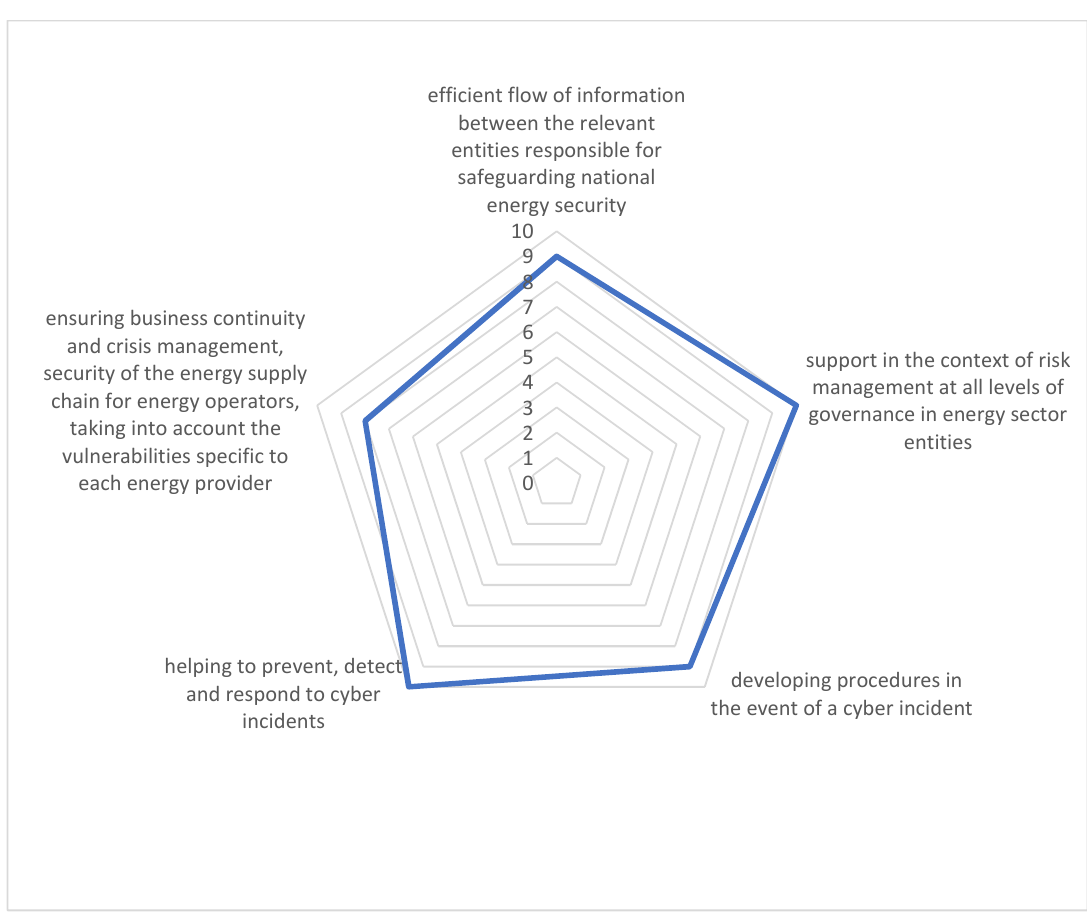
Figure 4. Desirable expectations affecting the energy security of critical infrastructure. Source: Au- thors’ own elaboration.